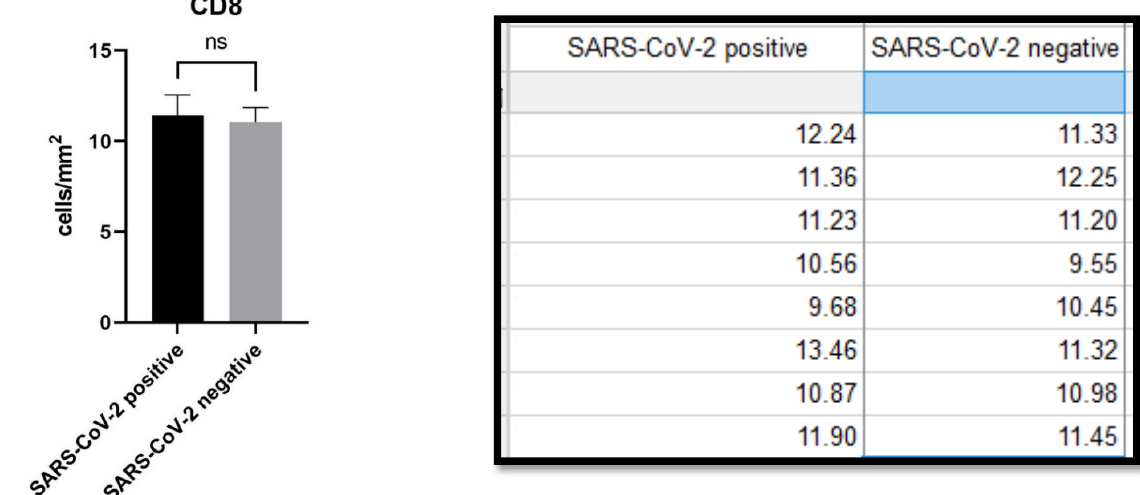
Figure 4. ( A ) Immunostaining for HMGB1 of a patient positive for SARS-CoV-2: note the internal positive control of nor- mal epidermal keratinocytes and positivity in the cells constituting the excretory portion of the eccrine sweat glands that were strongly positive for anti-S1 spike protein immunostaining by SARS-CoV-2 (Immunohistochemistry, Original Mag- nification: 40×). ( B ) Detail of extracellular release of HMGB1 (Immunohistochemistry, Original Magnification: 200×). ( C ) Immunostaining for HMGB1 of a patient negative for SARS-CoV-2: note the internal positive control and substantial neg- ativity in the cells of superficial dermis (Immunohistochemistry, Original Magnification: 40×). ( D ) Detail of negativity for HMGB1 (Immunohistochemitry, Original Magnification: 100×).